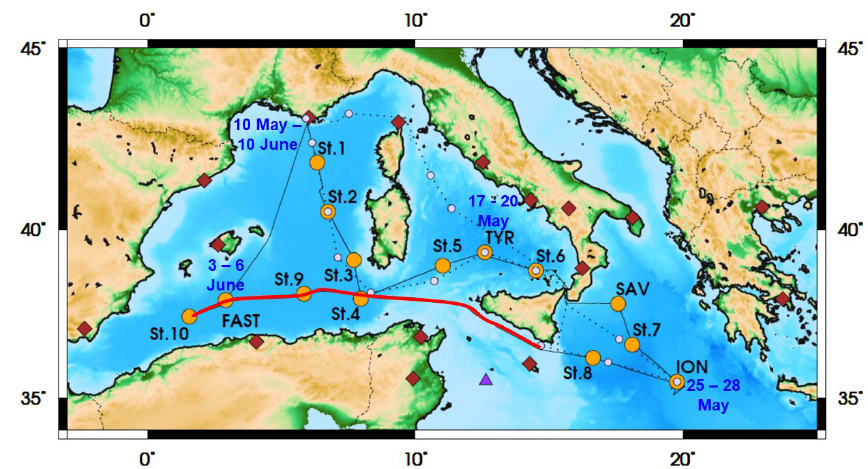
Figure 4. Transect of the PEACETIME cruise: initial (dotted line) and final tracks (continuous line); the red segment corresponds to the change of route to catch a dust deposition (see Sect. 4); stations are indicated by filled circles (planned stations: smaller, pink; realized: larger, orange). The 10 short stations are numbered from St.1 to St.10. TYR, ION and FAST indicate the three long stations. The SAV station was only performed for the retrieval and launch of floats. The land-based Lampedusa observatory (purple triangle) and 15 AERONET stations (Holben et al., 1998) operated during the cruise provided continuous daytime measurements of the spectral aerosol optical depth (AOD) are also represented (brown diamonds). Table 1. Date of occupation, position and depth of the short stations (ST1-ST10), of the long stations (TYR, ION, FAST) and of the SAV station. Arrival date Local Departure